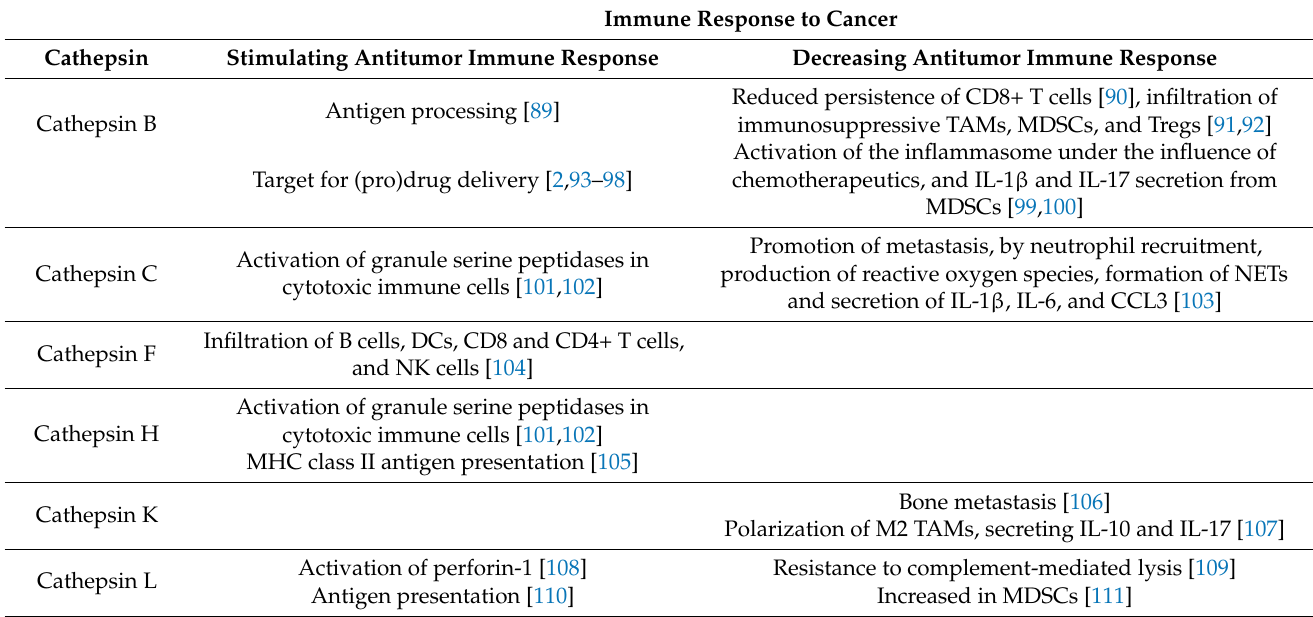
Table 2. The role of cysteine cathepsins in immune response to